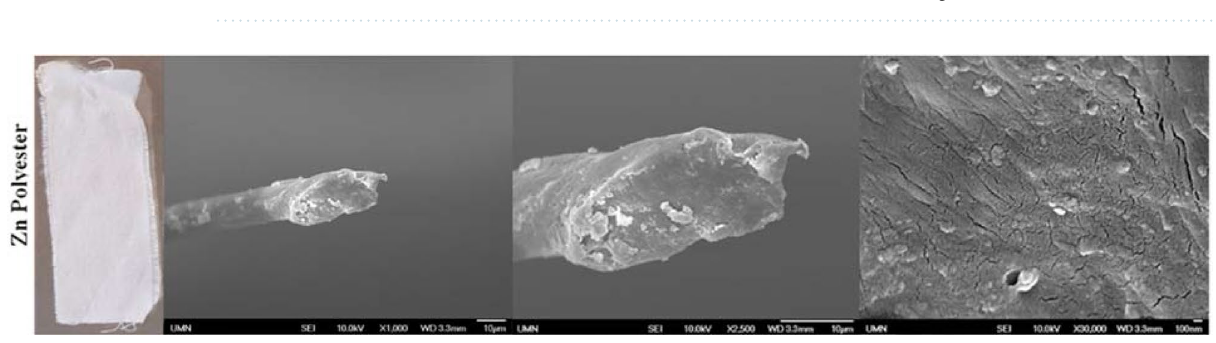
Figure 3. Versatility of the in situ nanoparticle growth process using different nanoparticles on different textiles. nSe: nanoselenium, nb: nanoboron, nCe: nanocerium, nFe: nanoiron, nAg, nanosilver.